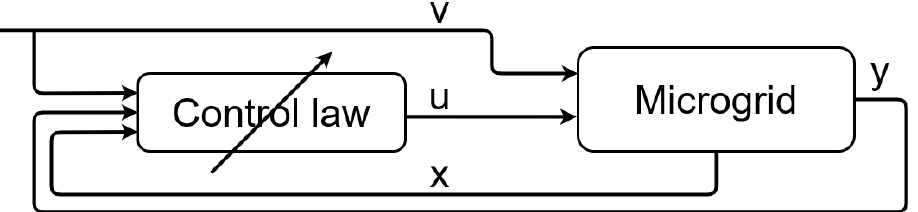
Figure 3. Schematic diagram of the chosen control system structure with switching between two hybrid model predictive control